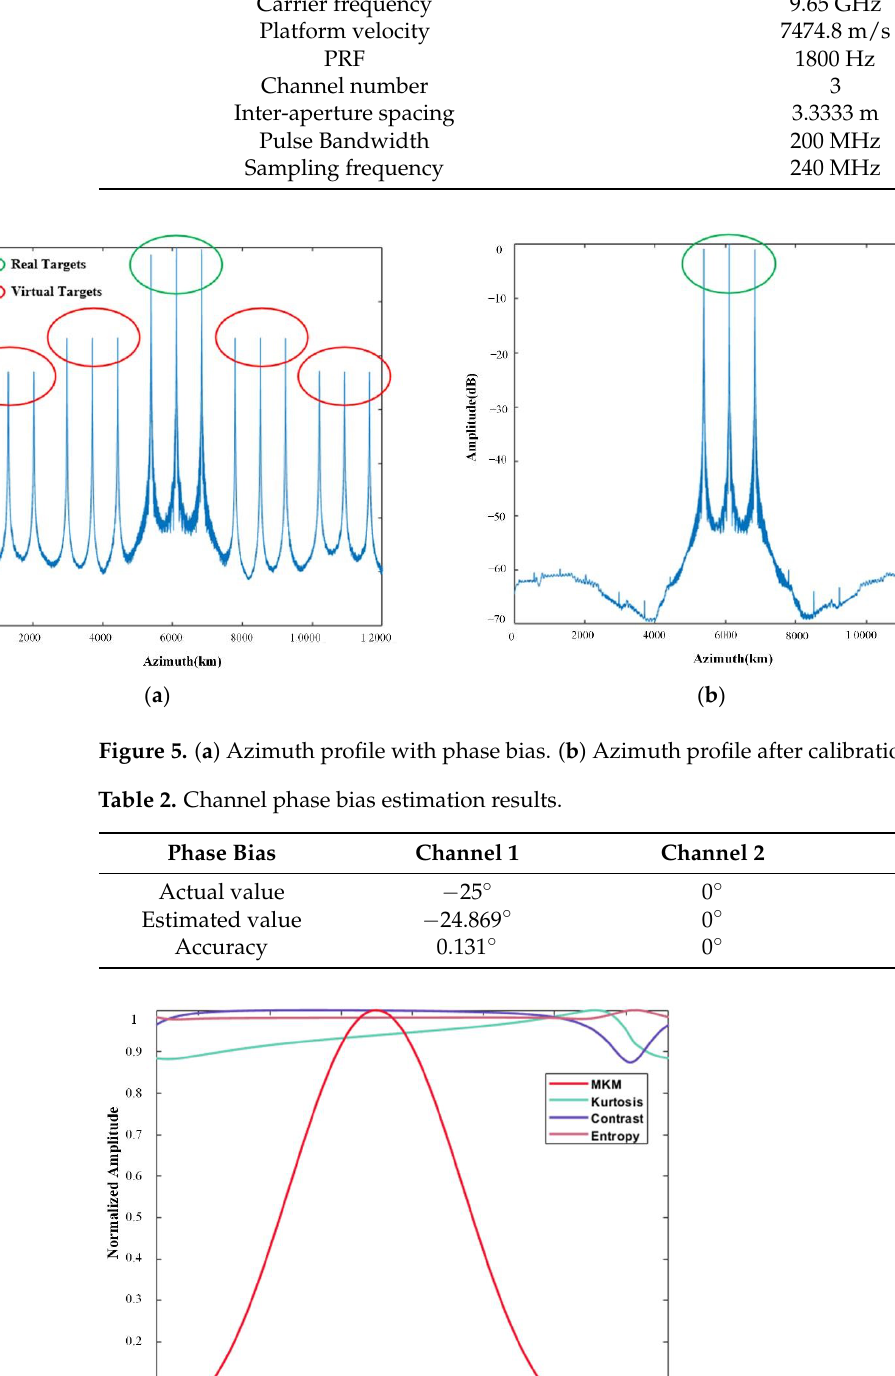
Figure 6. Curves of MMK, kurtosis, contrast, and entropy with phase. Table 1. Simulation parameters.